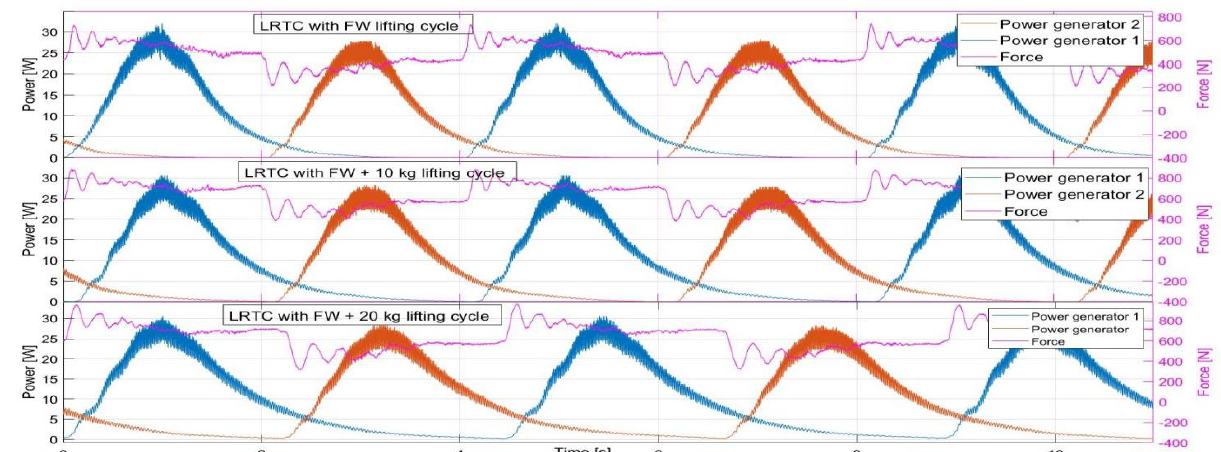
Fig. 14. The LRTC lifting cycle series for Exp. III. a, b and c. Sinusoidal motion with amplitude 300 mm, time period 4 s